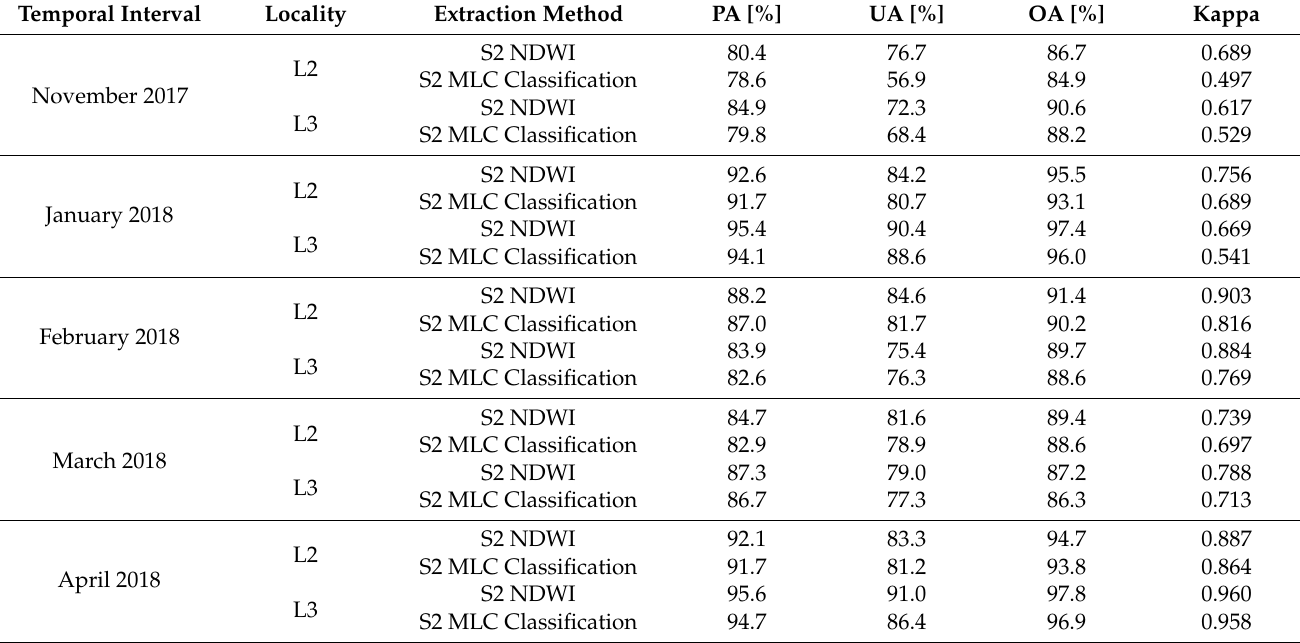
Table 7. The results of accuracy evaluation of extracted water